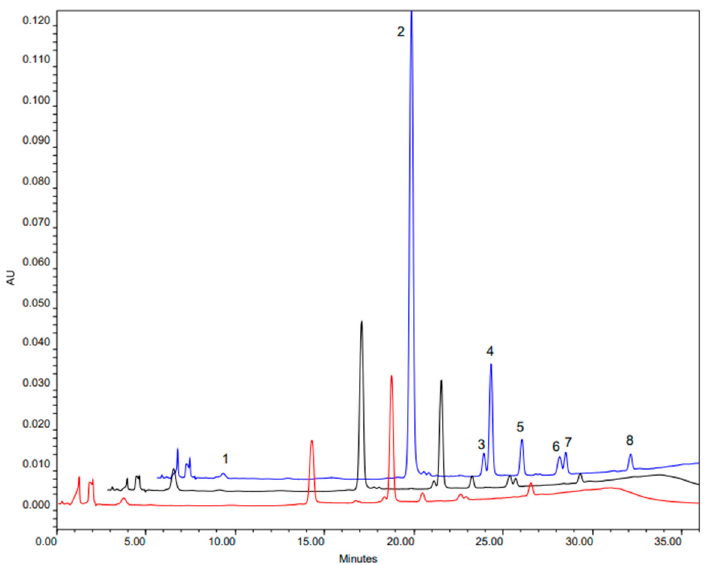
Figure 1. HPLC chromatogram of glucosinolate profile of turnip greens. Varieties: 143N5 (red), 143N7 (black) and 163N7 (blue). Peaks: (1) Progoitrin, (2) Gluconapin, (3) Glucobrassicanapin, (4) Glucotropaeolin (internal standard), (5) Glucobrassicin, (6) 4-Metoxyglucobrassicin, (7) Gluconasturtin, (8) Neoglucobrassicin.